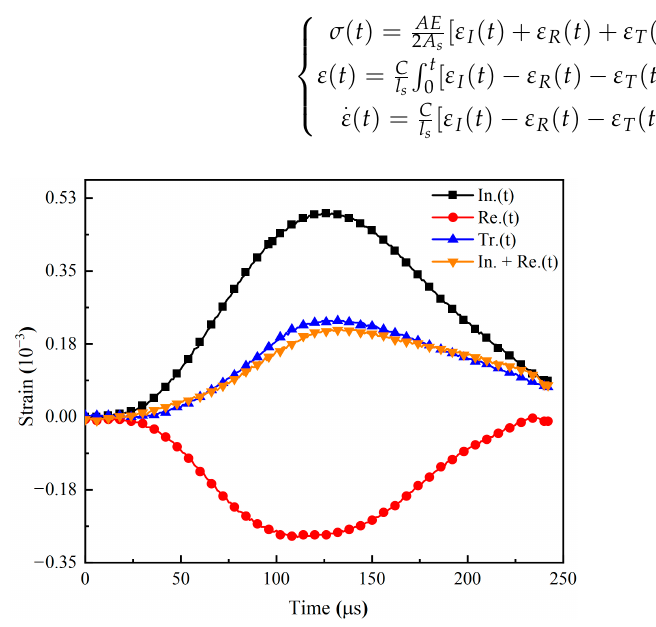
Figure 9. Dynamic stress equilibrium for a typical compression test.